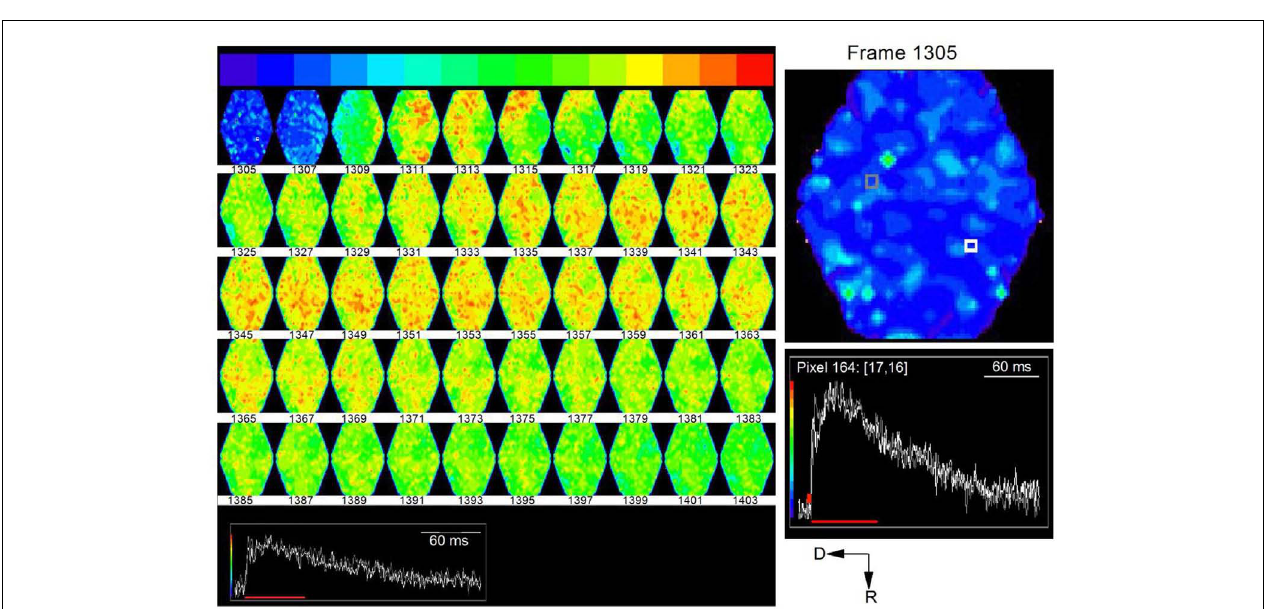
region of the response covered by frames 1305–1403.To utilize the full range of colors, the baseline that precedes the response has been set to blue and the peak of the response to red. Right panel, Expanded image of the first frame, 1305, with inset traces of corresponding to the white and gray